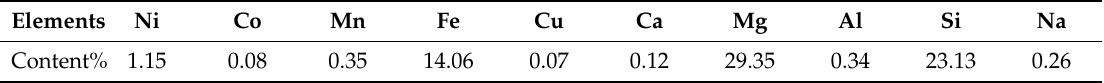
Table 1. The content of di ff erent elements in laterite